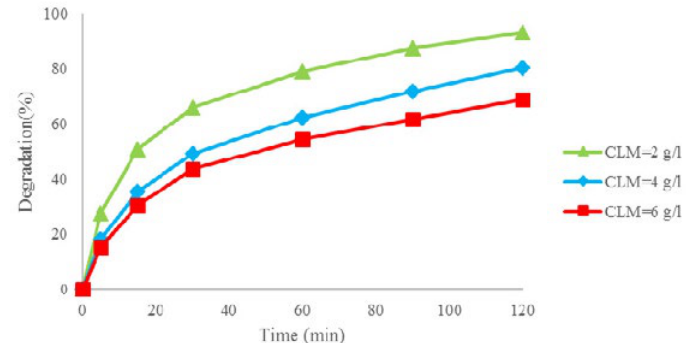
Fig. 4. Effects of Clindamycin concentration on photocatalytic degradation Fig. 4 Effects of Clindamycin concentration on photocatalytic degradation